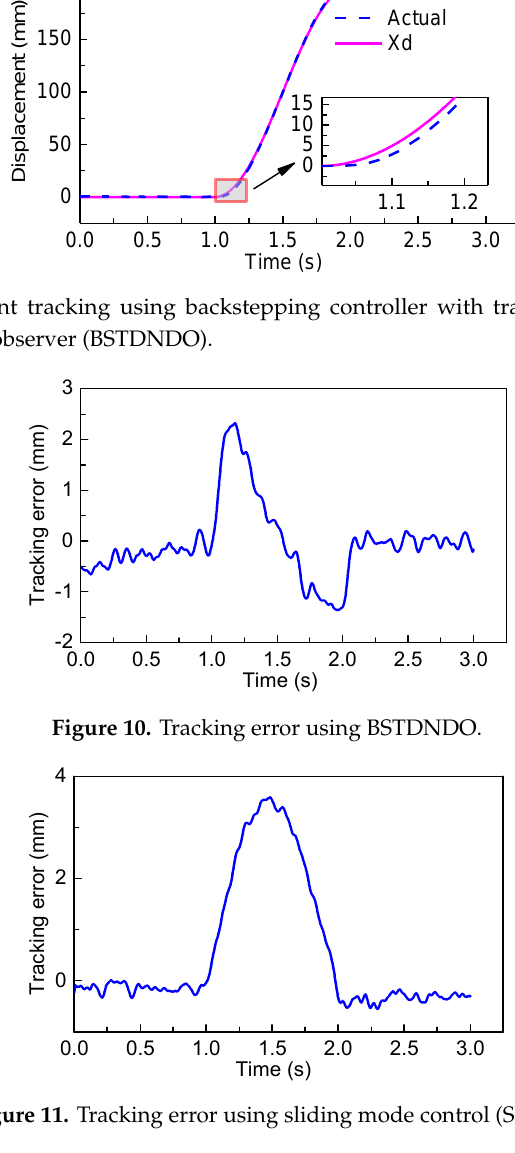
Figure 11. Tracking error using sliding mode control (SMC).